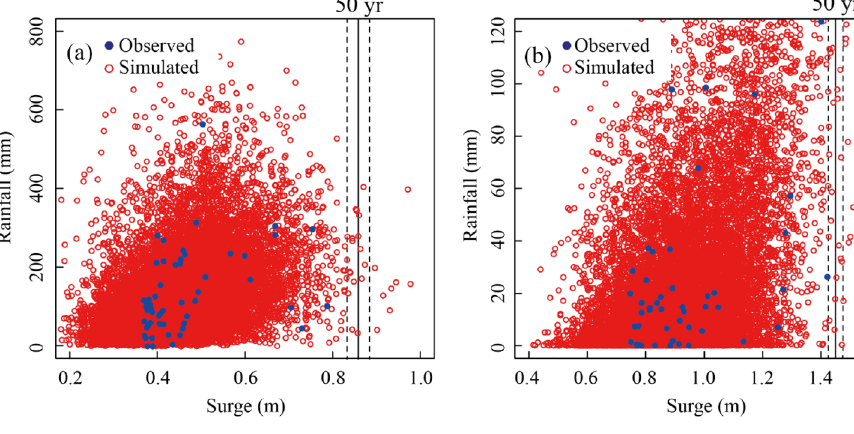
Fig. 6 Comparison of annual maximum rainfall and condi- tional rainfall at A2 ( a ) and C4 ( b ) locations with all the pairs; dashed vertical lines are the median value of